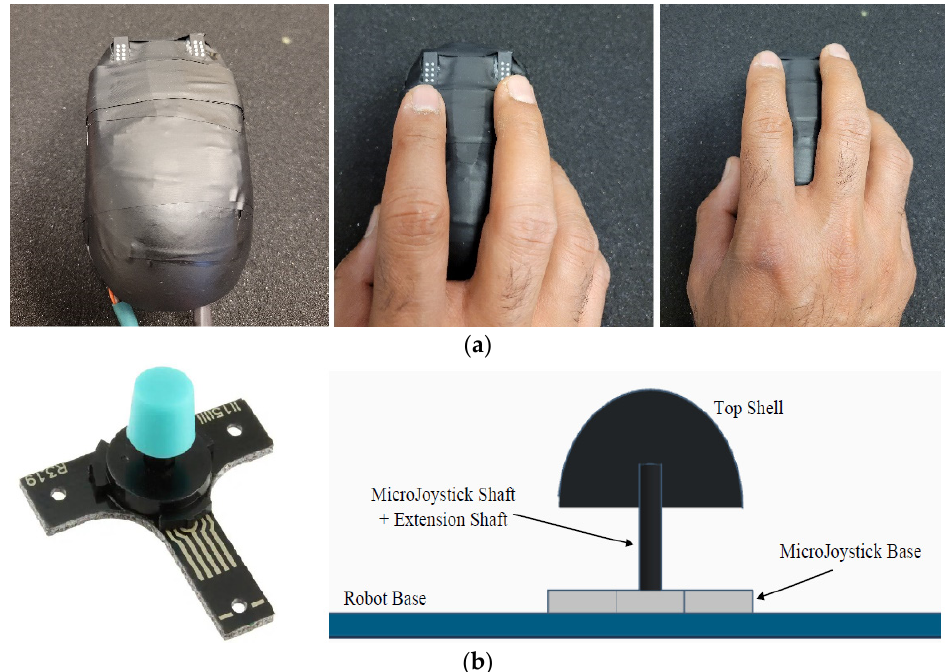
Figure 5. ( a ): Sensor cap block consisting of the top shell, force-sensing system, and tactile display; ( b ): MicroJoystick (left) and connection between the robot base, MicroJoystick, and top shell (right).